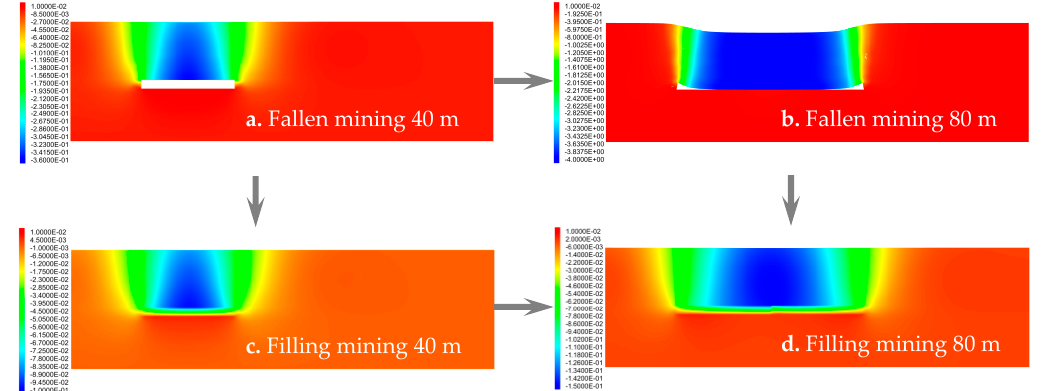
Figure 21. The Z-direction displacement field of the strata (Y-Z profile at X of 80 m) at mining distances of 40 m to 80 m under fallen mining and filling mining with n = 0.6 cemented rockfill. Fallen mining at 40 m ( a ); Fallen mining at 80 m ( b ); Filling mining at 40 m ( c ); and, Filling mining at 80 m ( d ).